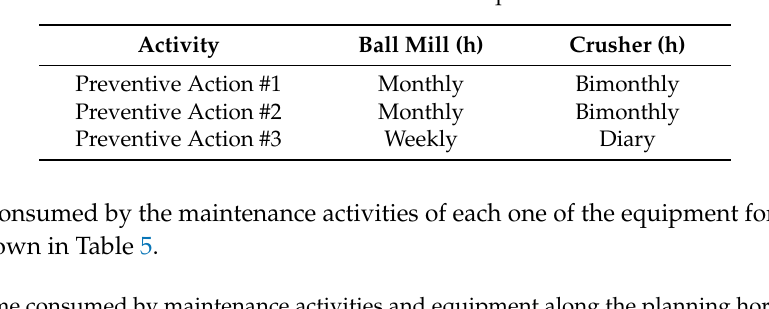
Table 4. Preventive actions frequencies.